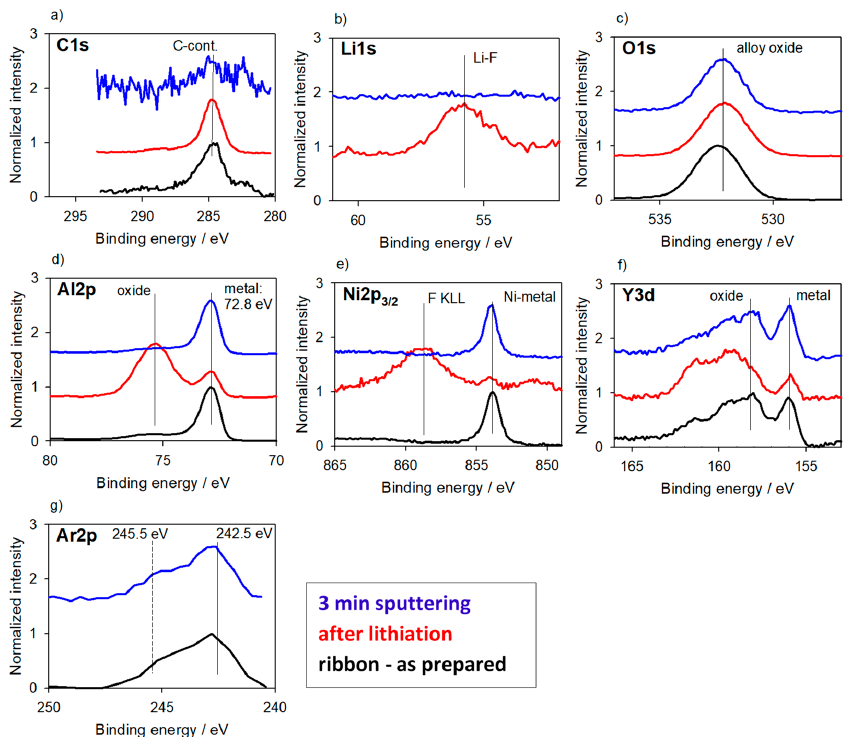
Figure 8. XP spectra normalized in intensity of AlYNi-based amorphous ribbons: as prepared (shortly sputter cleaned), after electrochemical lithiation without and with sputter cleaning ( bottom to top ). BE calibration was done as for Figure 7 with Al2p (72.8 eV—metal). No intercalation but only plating of Li(O)F is observed. Ni is at fewest and Y at most oxidized. All peaks are in the positions expected for standard C1s BE calibration, too. Ar2p also at low BE position (242.5 eV—measured separately with lower energy resolution). ( a ) C1s; ( b ) Li1s; ( c ) O1s; ( d ) Al2p; ( e ) Ni2p 3/2 ; ( f ) Y3d; ( g ) Ar2p